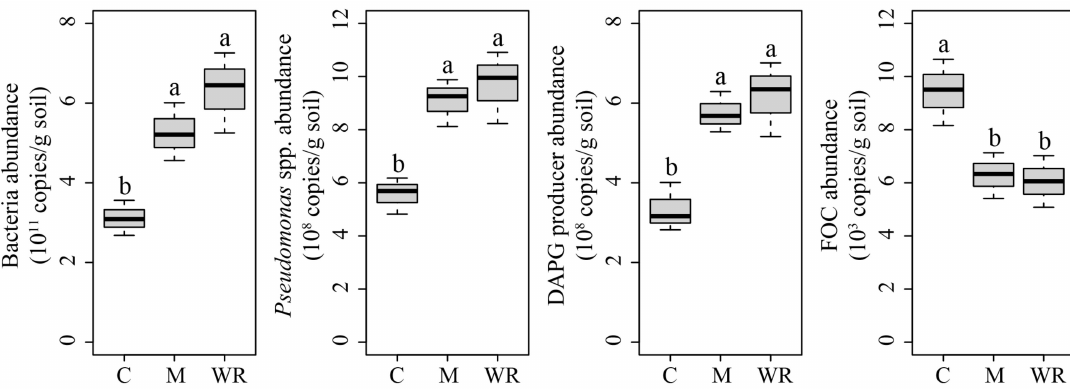
Figure 1. Cucumber rhizosphere bacteria, Pseudomonas spp. 2,4-diacetylphloroglucinol (DAPG) producer and Fusarium oxysporum f.sp. cucumerinum (FOC) abundances. C, M and WR represent treatments of cucumber monocropping, rotations with Indian mustard and wild rocket, respectively. Different letters indicate statistically significant differences among treatments (Tukey’s HSD, p < 0.05).